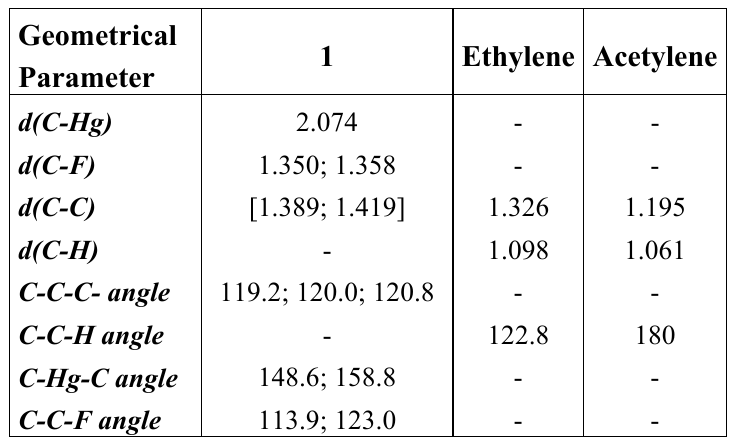
Table 1. Main structural data derived from the AM1 study for 1 and X